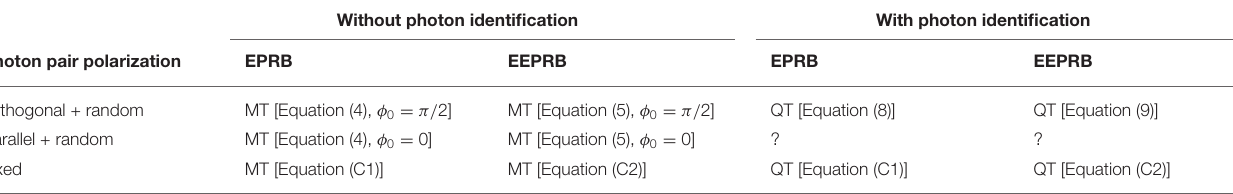
TABLE 1 | Overview of the agreement between the DES results and the theoretical descriptions of the (E)EPRB experiments. Without photon identification With photon identification Photon pair